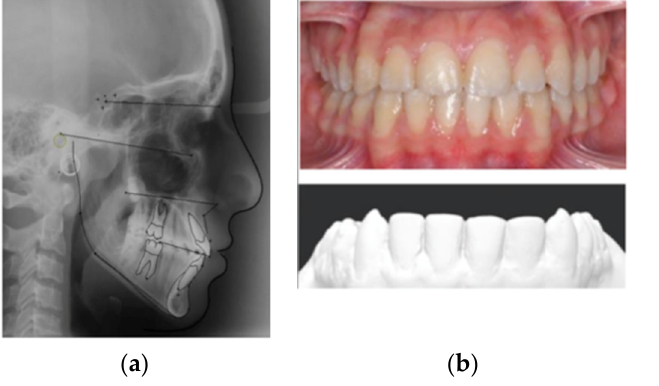
Figure 1. Post-orthodontic treatment records: cephalometrics ( a ), photographs, and dental casts ( b ). The orthodontic treatment performed in all cases involved in this study included maxillary expander and/or transpalatal arch in the upper and lip bumper in the lower arch during mixed dentition followed by multibracket fixed appliances (MBT prescription) and retention at the end of